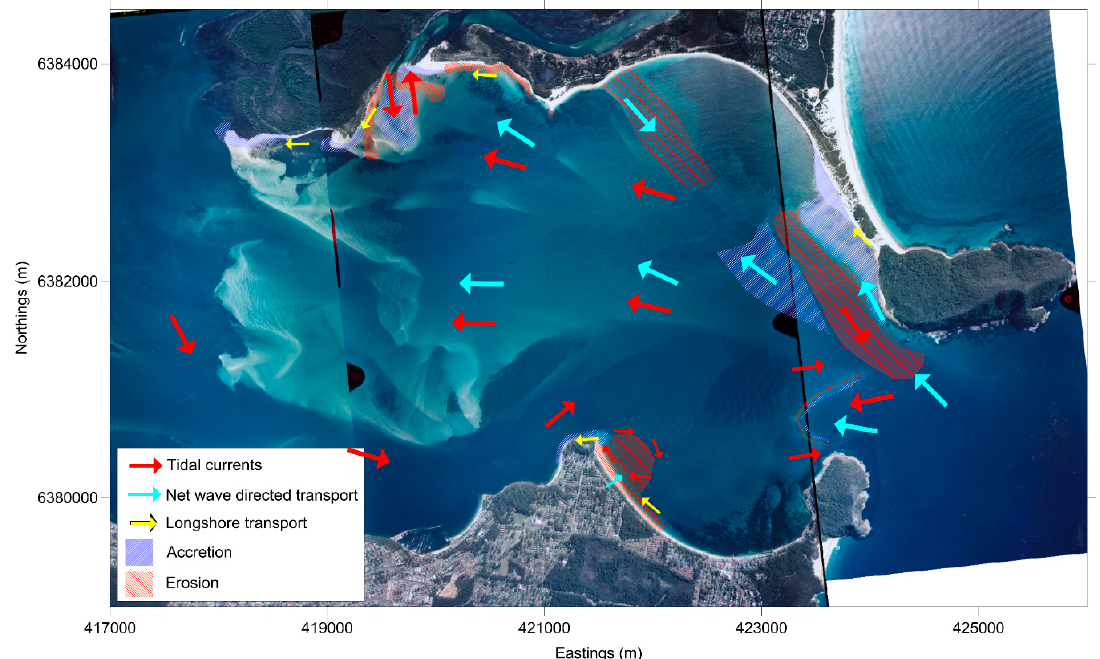
Figure 6. Sediment sinks and sources including the interaction forces of tidal currents and ocean waves that drive the sediment transport pathways. Arrows are scaled to the relative contribution to sediment transport. (Grid coordinates are in MGA Zone 56.)